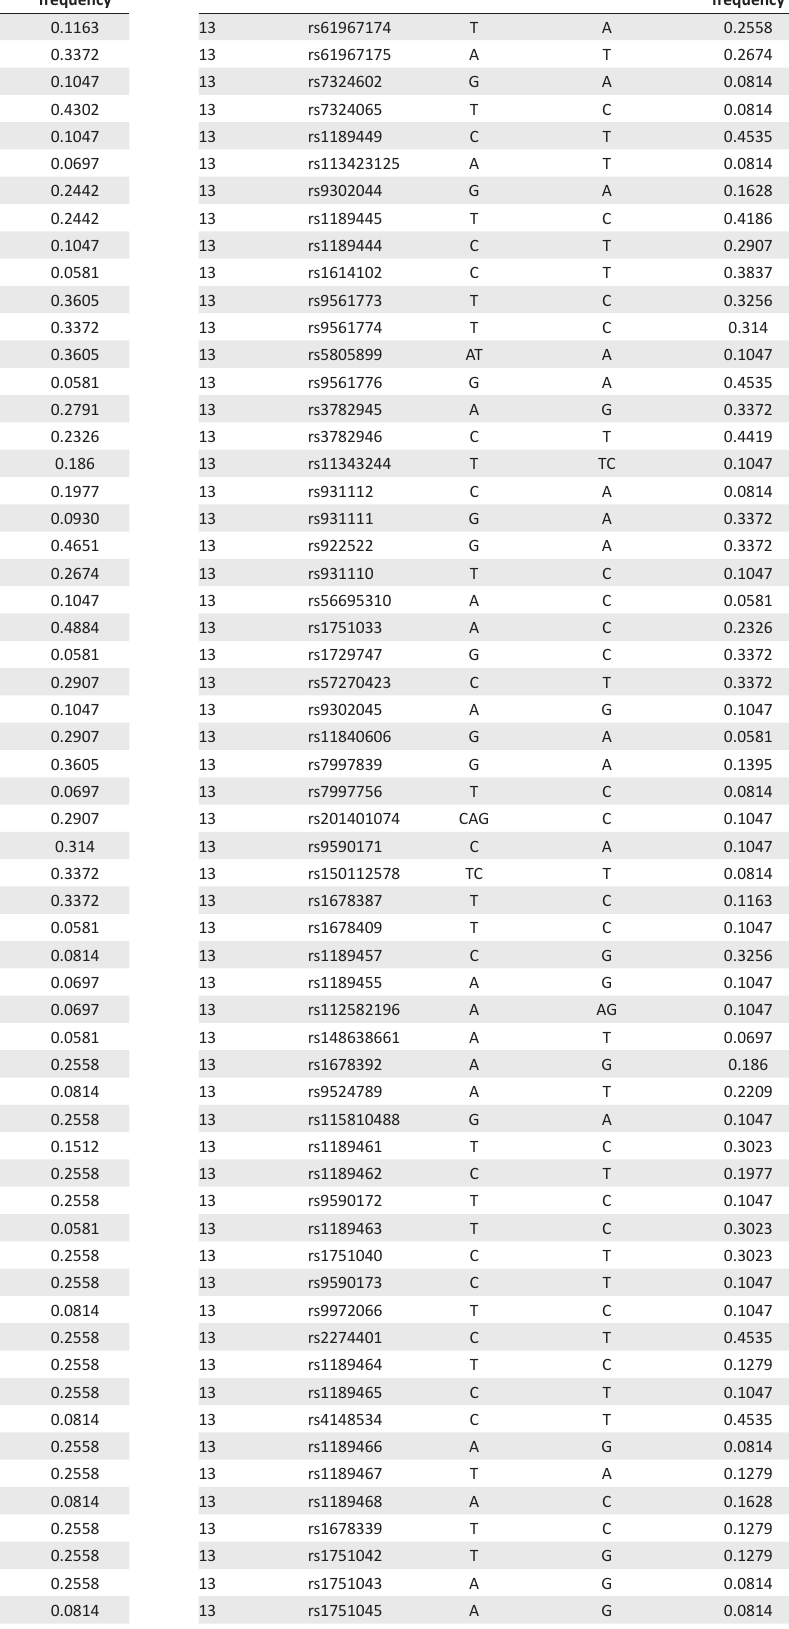
Table 1-A1 (Continues...): Minor allele frequencies for 1846 polymorphisms in 43 black South Africans. Chromosome Polymorphism Minor allele Major allele